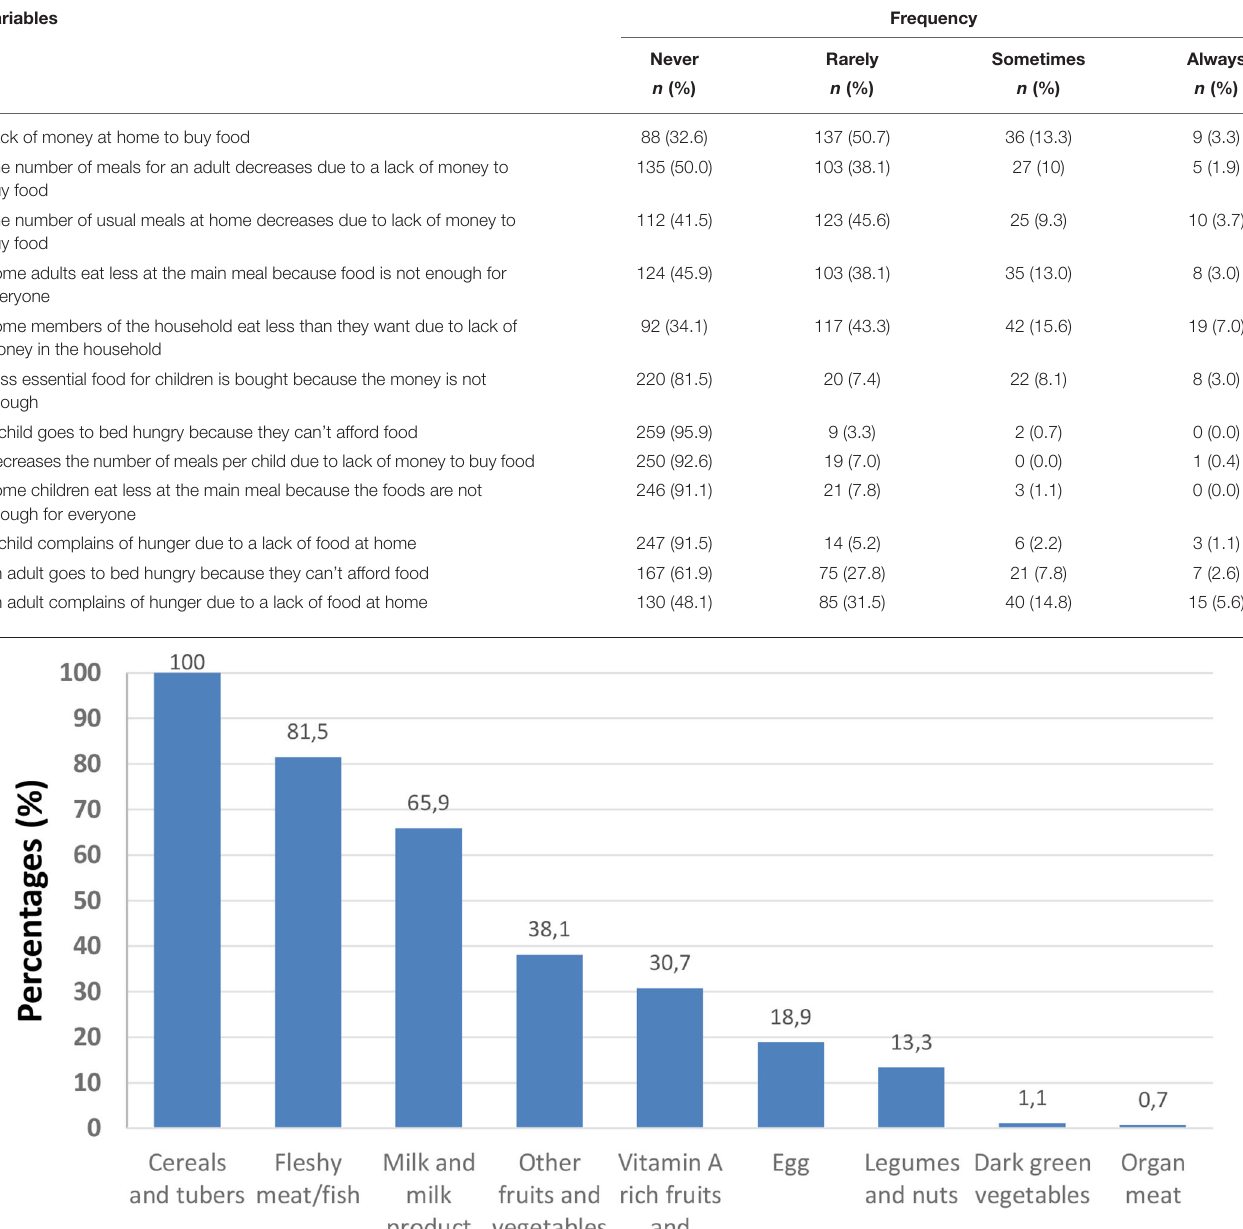
be easily interpretable. Table 4 shows the results of comparing the different models